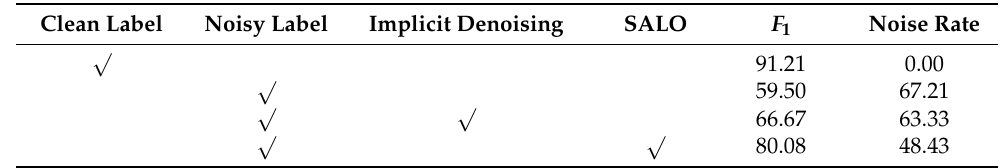
Table 7. Correlations between F 1 score (in %) and Noisy Rate (in %) of training labels with different noise label refinery strategies on